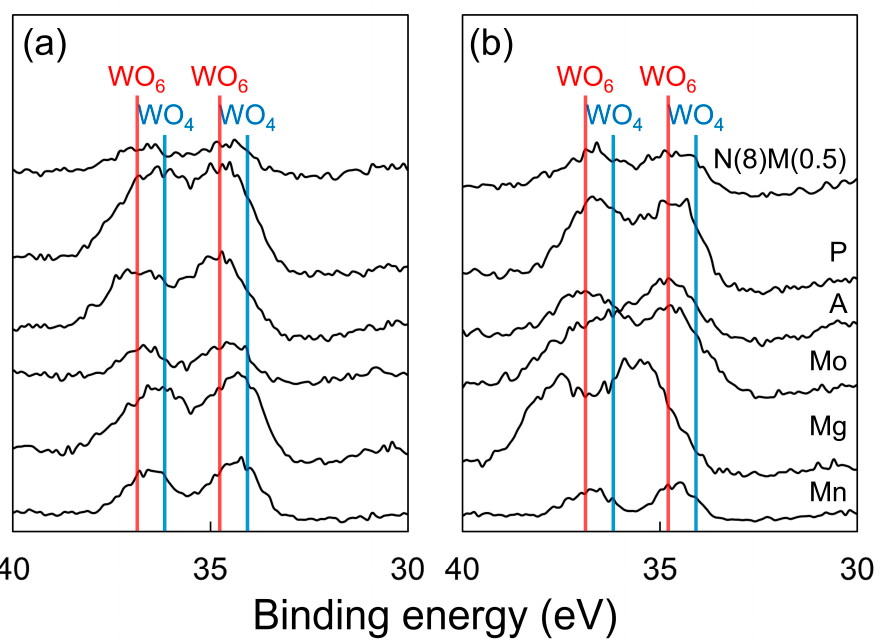
Figure 5. W 4f X-ray photoelectron spectroscopy results of ( a ) fresh and ( b ) spent catalyst pellets depending on the inorganic binders .